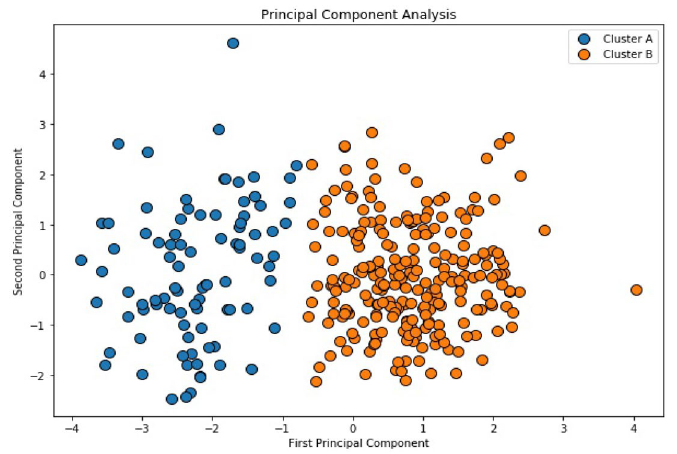
Figure 2. Principal Component Analysis (PCA)